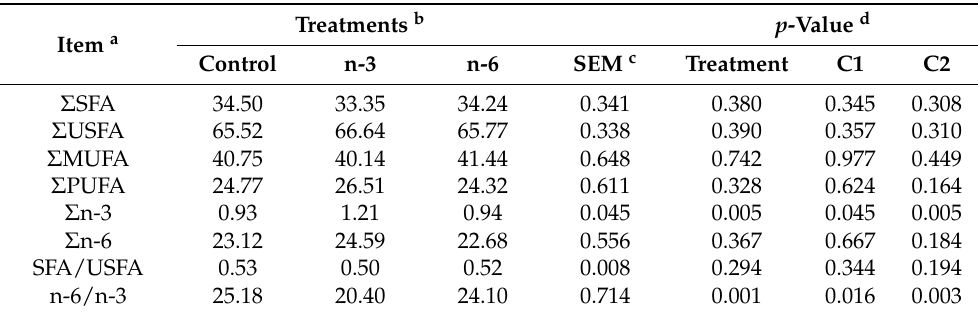
Table 8. Effect of supplementation of milk enriched with n-3 and n-6 on the quality of the lipid fraction of sows’ colostrum.